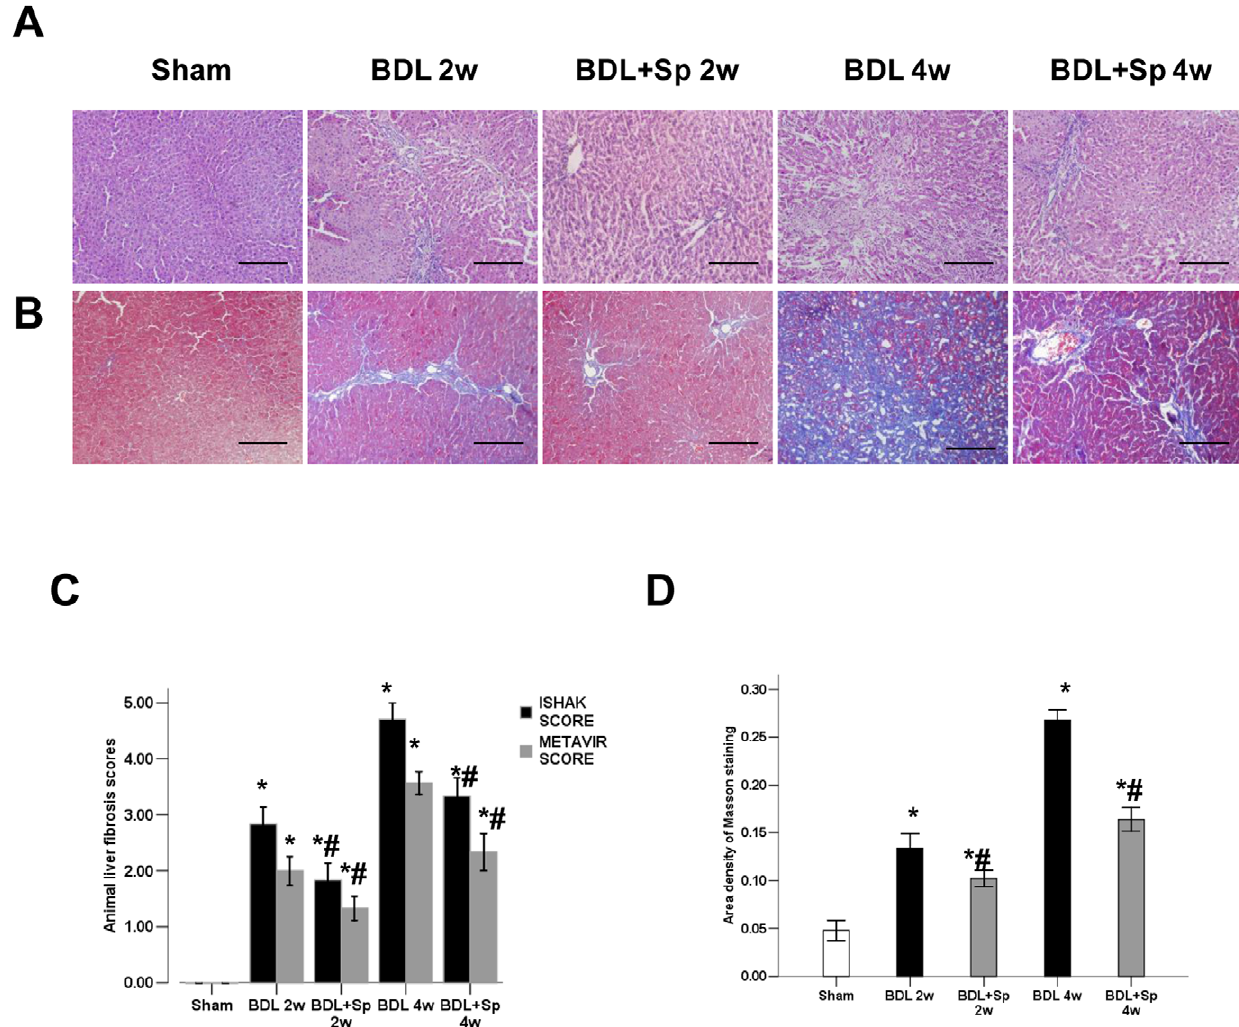
Figure 1. Therapeutic effects of Spironolactone (Sp) on hepatic fibrosis in BDL rats. Histological images of rat livers stained with H&E (A) or Masson (B) (magnification 200 6 ). Liver fibrosis scores (C) and Semiquantitative measurement of Masson staining (D) in spironolactone or vehicle- treated BDL rats. * p , 0.05 compared to the Sham group. # p , 0.05 compared to the BDL groups.